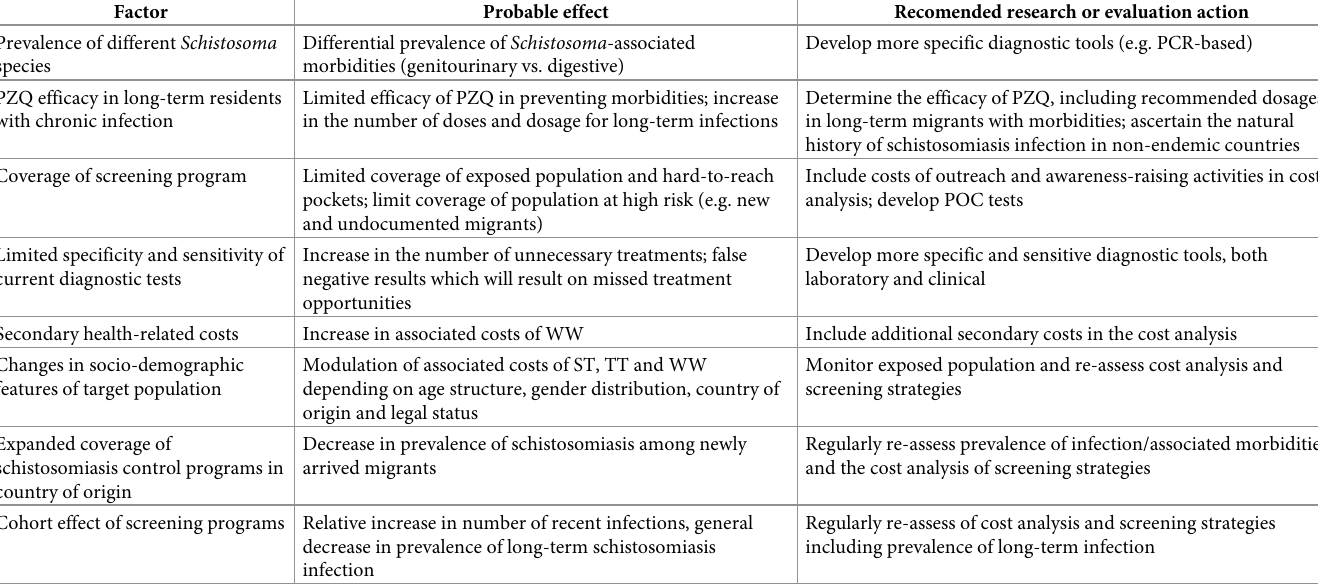
Table 3. Potentially intervening factors, probable effects and recommended actions related to the implementation of schistosomiasis screening program in a non- endemic